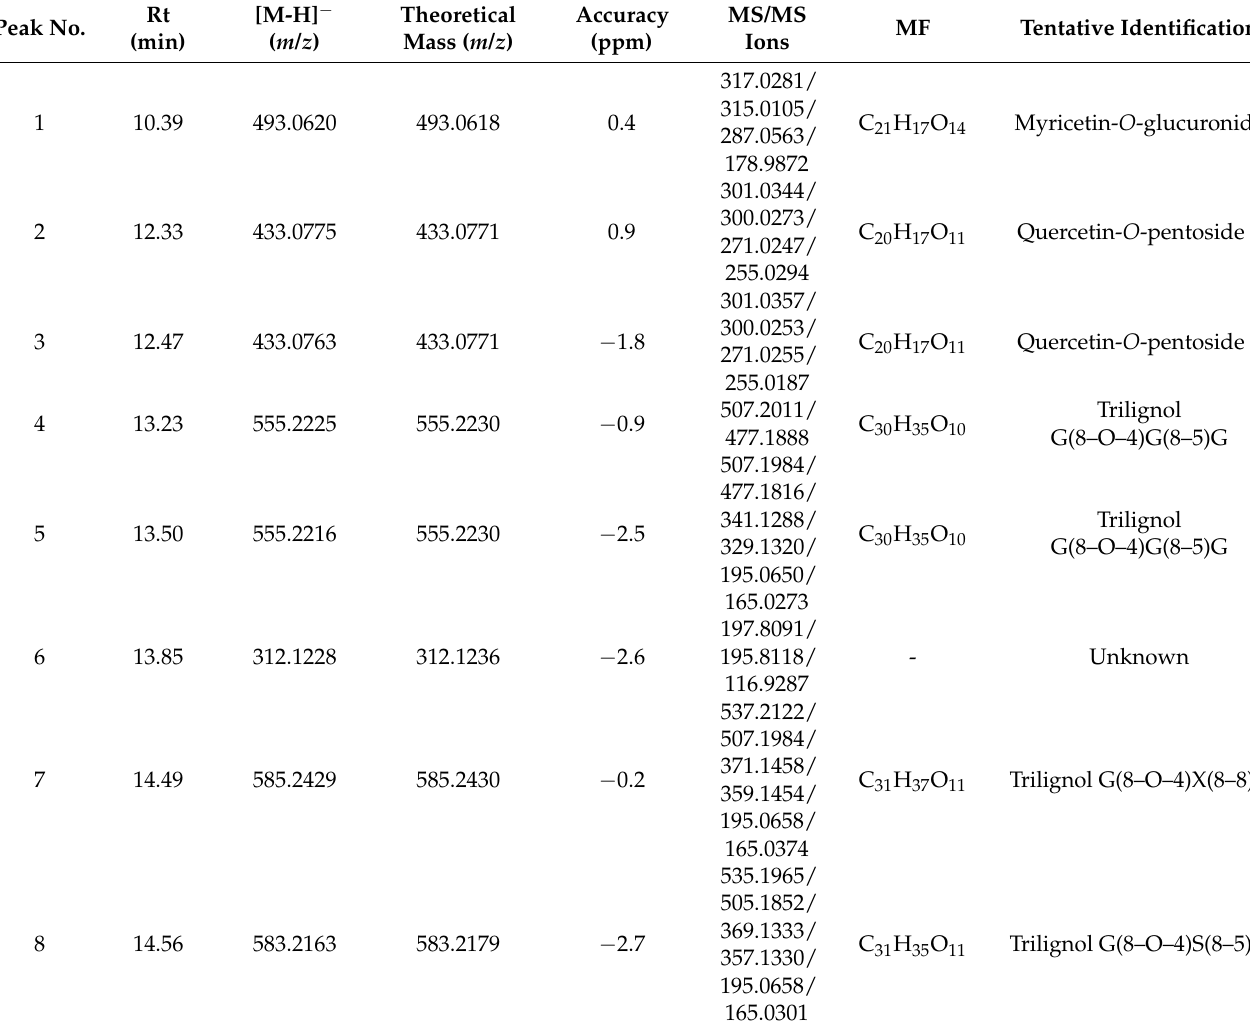
Table 2. Chemical composition of the methanol 90% fraction of the total extract of C. cowellii .